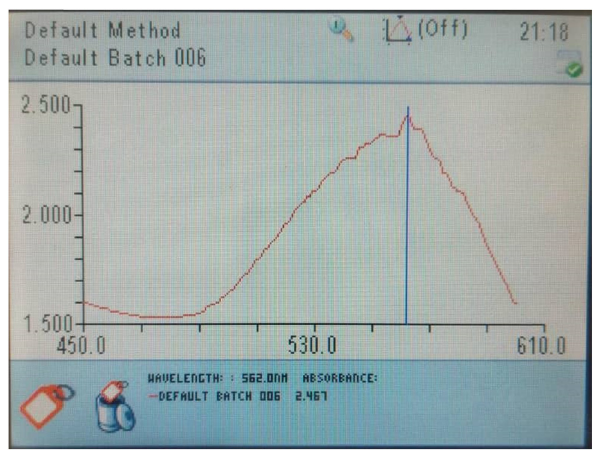
Figure 8: UV - Vis spectra of the mixture solution containing synthe - sized Au NPs and A. urumiana extract, after synthesis with UV radiation, at obtained optimum synthesis conditions.